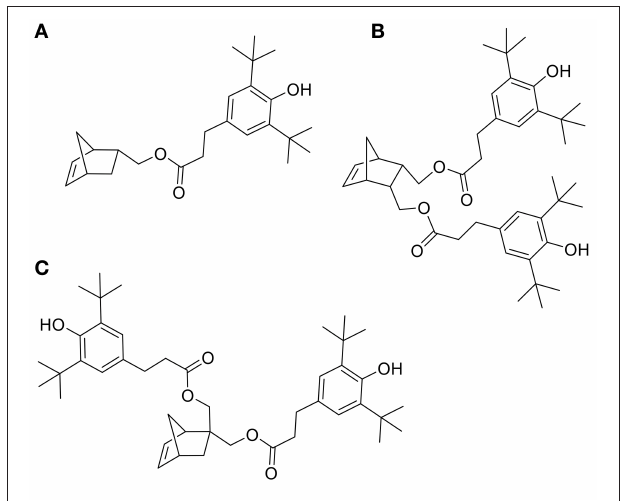
FIGURE 1 | Monomers (A–C) used in ROMP by